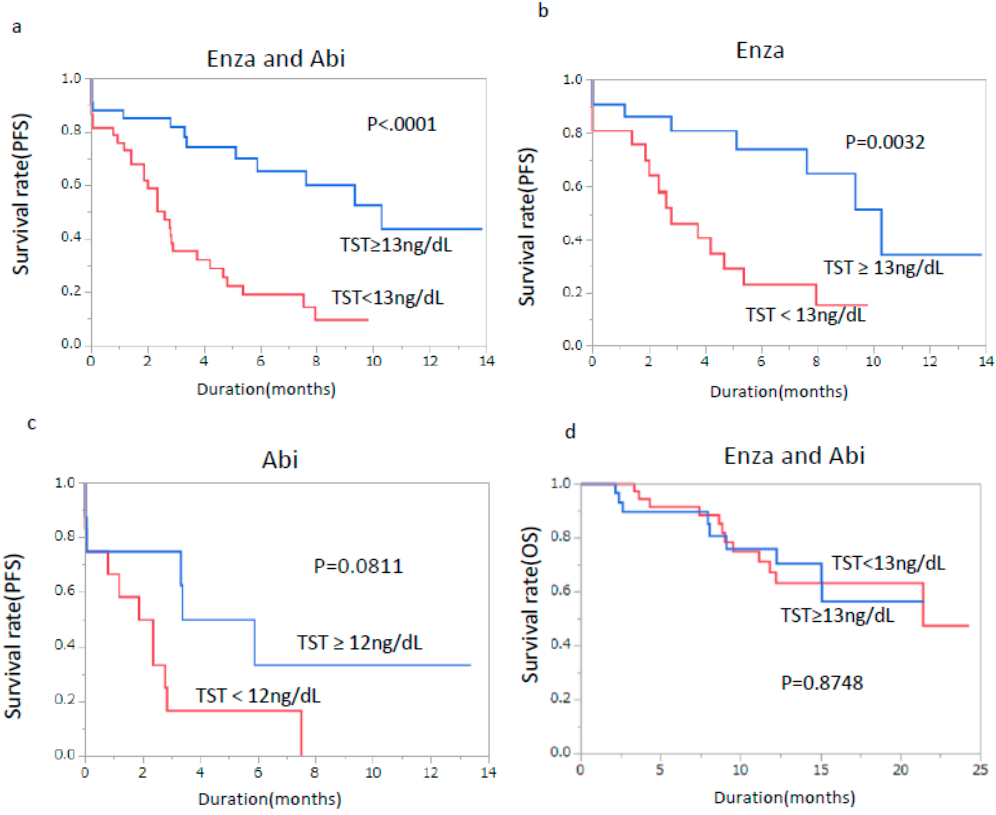
Figure 1. Progression-free survival according to TST levels. ( a ) Progression-free survival according to TST level <13 ng/dL or ≥ 13 ng/dL as the cut-off values in enzalutamide- and abiraterone-treated patients. ( b ) Progression-free survival according to TST level <13 ng/dL or ≥ 13 ng/dL as the cut-off values in enzalutamide-treated patients. ( c ) Progression-free survival according to TST level <12 ng/dL or ≥ 12 ng/dL as the cut-off values in abiraterone-treated patients. ( d ) Overall survival according to TST level <13 ng/dL or ≥ 13 ng/dL as the cut-off values in enzalutamide- and abiraterone-treated patients.